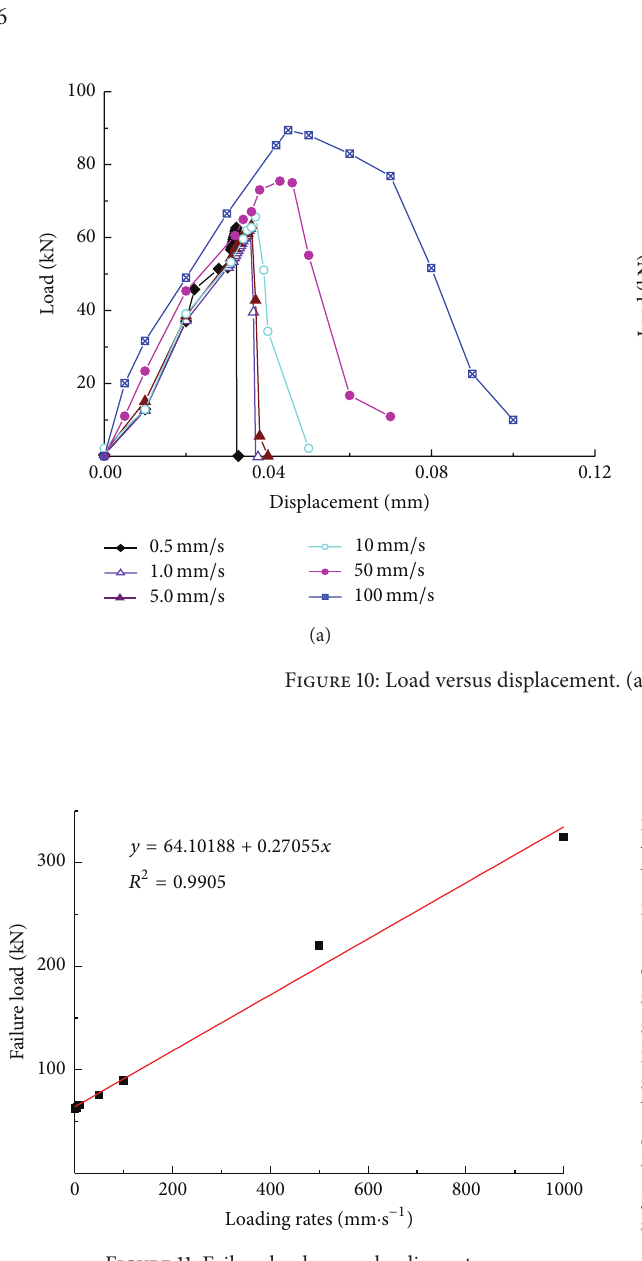
Figure 11: Failure load versus loading